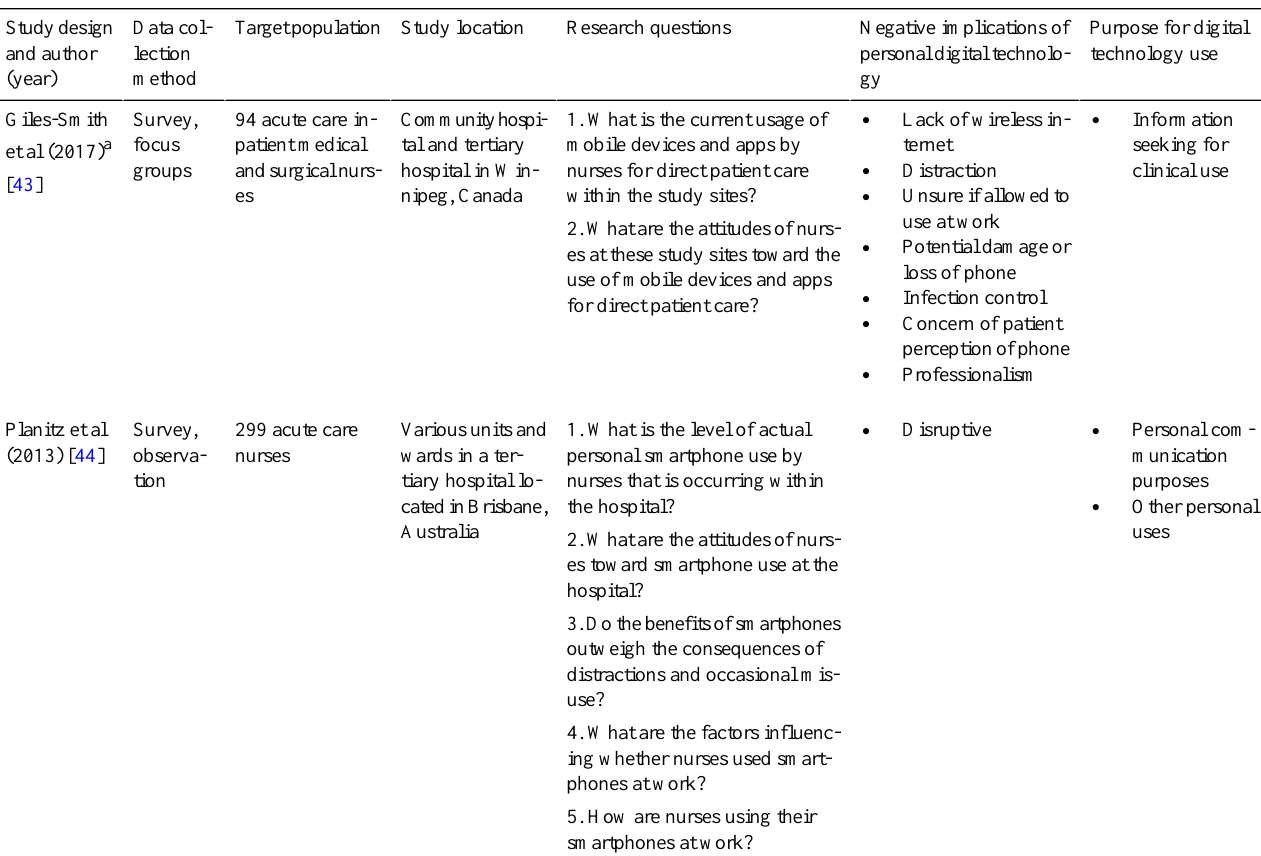
Table 3. Included mixed methods studies.